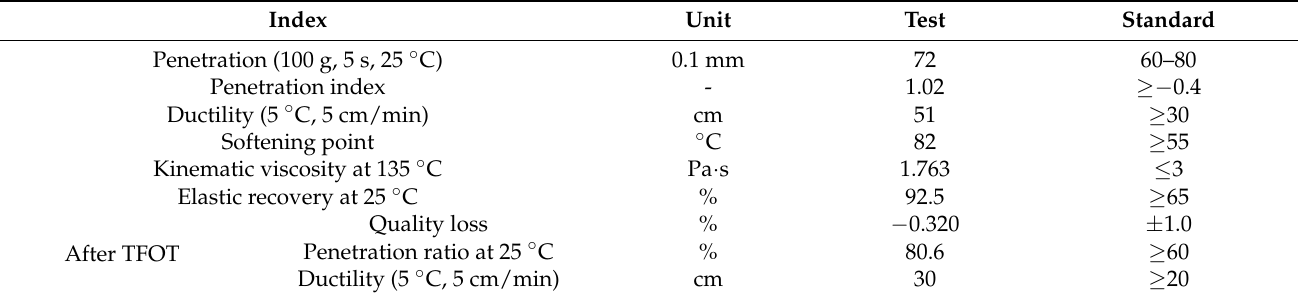
Table 5. Properties of SBS I-C for SSAM.